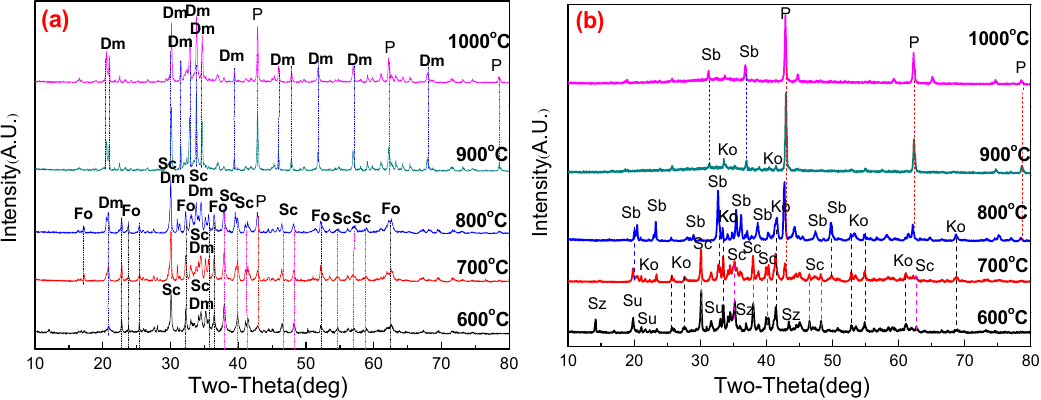
Figure 8. XRD patterns of ( a ) mixture of lizardite and sodium carbonate (lizardite to sodium carbonate molar ratio 1:2) and ( b ) mixture of szaibelyite and carbonate (szaibelyite to sodium carbonate molar ratio 1:1) at different temperatures for 60 min in a nitrogen atmosphere. Sc—Sodium carbonate (Na 2 CO 3 ); Fo—Forsterite (Mg 2 SiO 4 ); Dm—Disodium magnesiosilicate (Na 2 MgSiO 4 ); P—Periclase (MgO); Sz—szaibelyite (Mg 2 B 2 O 4 (OH) 2 ); Su—suanite (Mg 2 B 2 O 5 ); Ko—kotoite (Mg 3 B 2 O 6 ); Sb—Sodium borate.